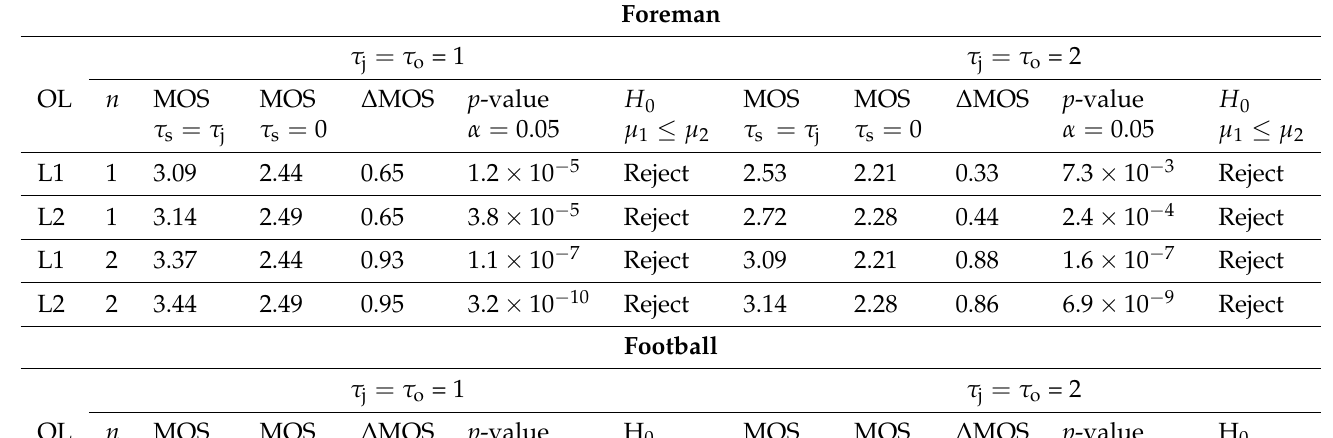
Table 5. Analysis of the impact of the sender buffer using Student’s t -test.